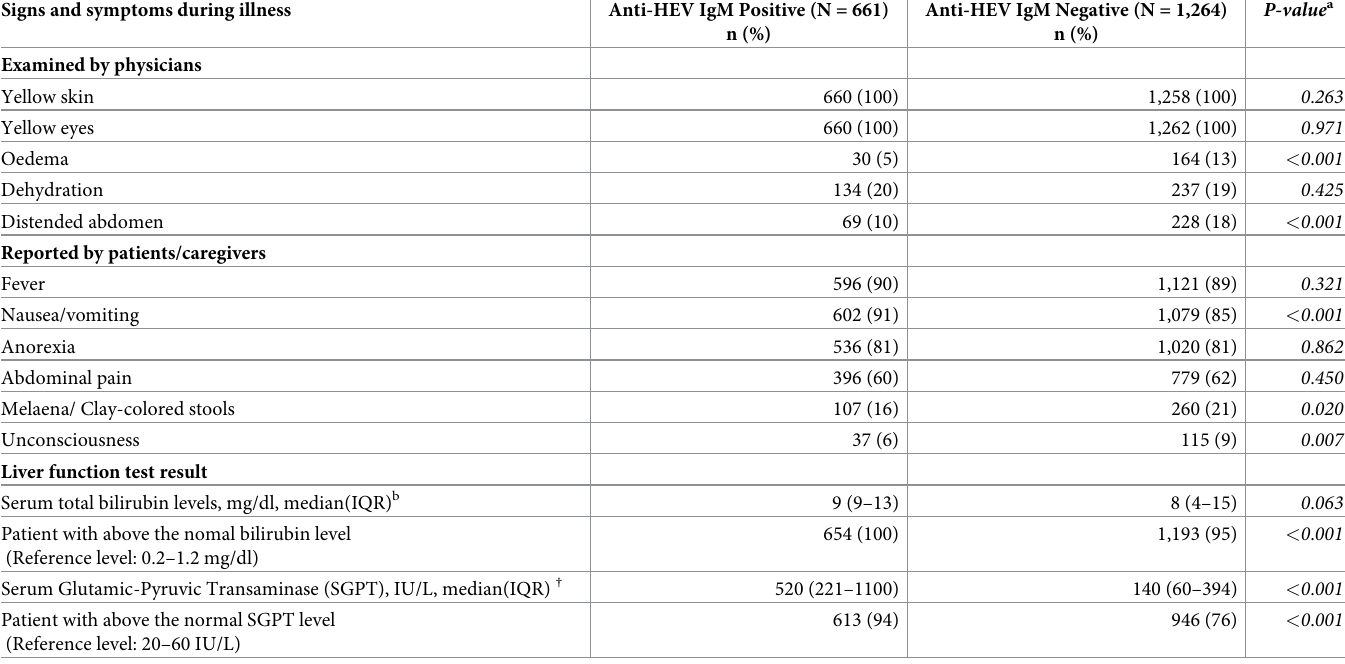
Table 2. Signs and symptoms during illness among anti-HEV IgM positive and negative patients admitted in six tertiary hospitals in Bangladesh, December 2014– September